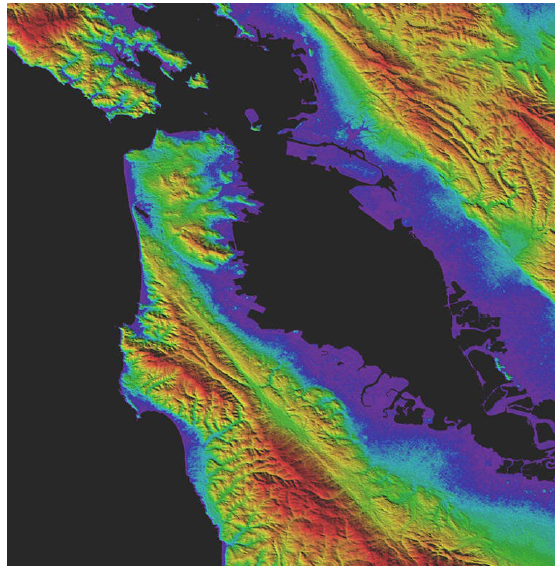
Figure 2 . Colorized perspective view of San Francisco Bay from ASTER GDEM V3 data.